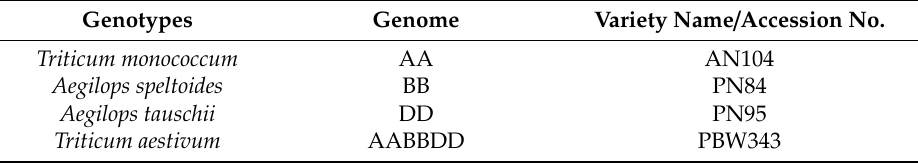
Table 1. Di ff erent diploids and hexaploid wheat accessions used in the study. Genotypes Genome Variety Name / Accession No. Triticum monococcum AA AN104 Aegilops